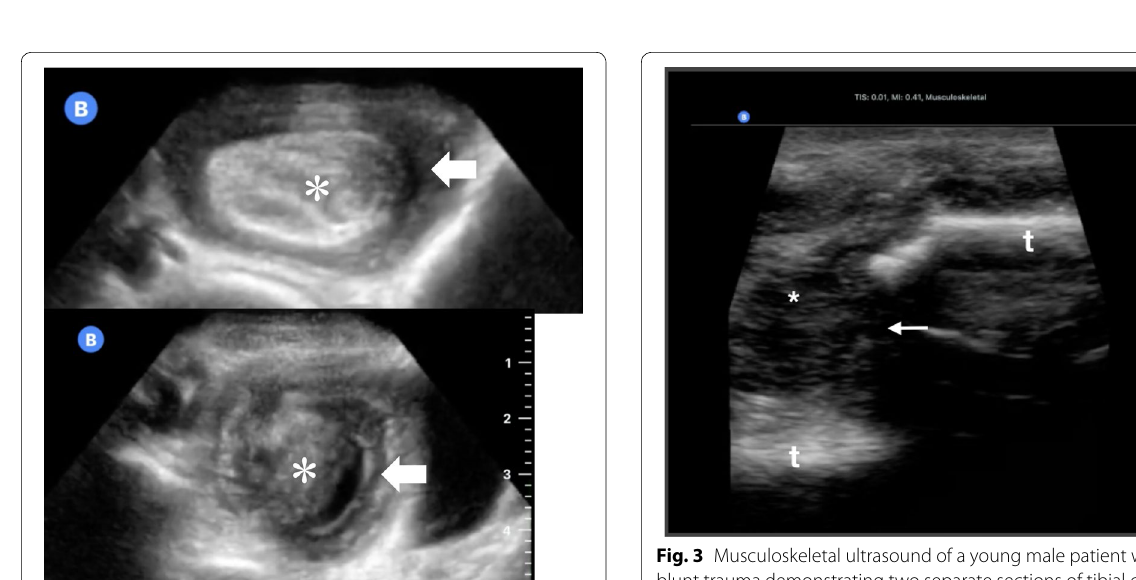
Fig. 1. 3-month-old male presenting with acute respiratory distress. POCUS revealed a dilated right atrium and ventricle with a prominent atrial septal defect, seen in parasternal long view (left) and a slightly modified apical four chamber view (right). LA, Left Atrium, LV, Left Ventricle, RA, Right Atrium, RV, Right Ventricle, *, Atrial Septal Defect